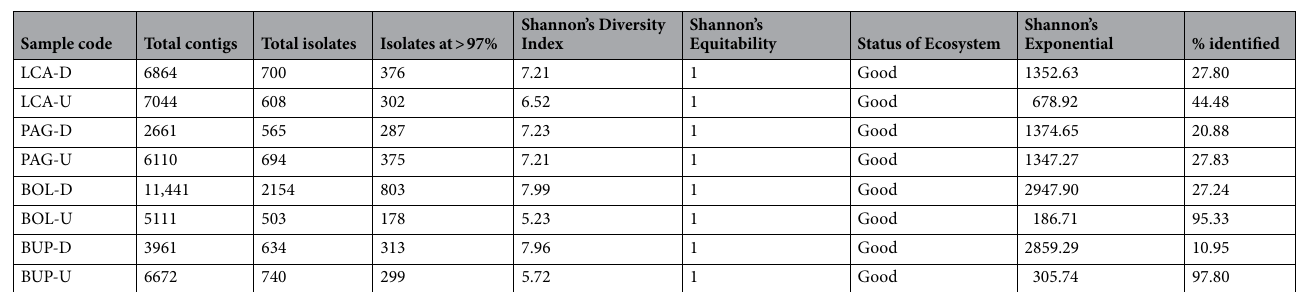
Table 2. Metagenomics counts and analysis of Shannon’s index of diversity, equitability and exponential results together with the percentage of species identified out of the total population estimated by Shannon’s exponential. As all the Shannon’s diversity index results are above 3 they represent a good ecosystem status. Shannon’s Equitability of 0.8 or above demonstrates even sampling across the species in the total population. Shannon’s Exponential gives an estimate of the total population size allowing the number of species identified to be estimated based on this and the number of isolates characterised at > 97% identity. Sampling codes are three letters for the location, number for the site and D or U for damaged or undamaged surface. LCA is Lincoln Cathedral, PAG is Saint Peter-at-Gowts, BOL is Saint Botolphs-by-Bargate and BUP is St. Nicholas,